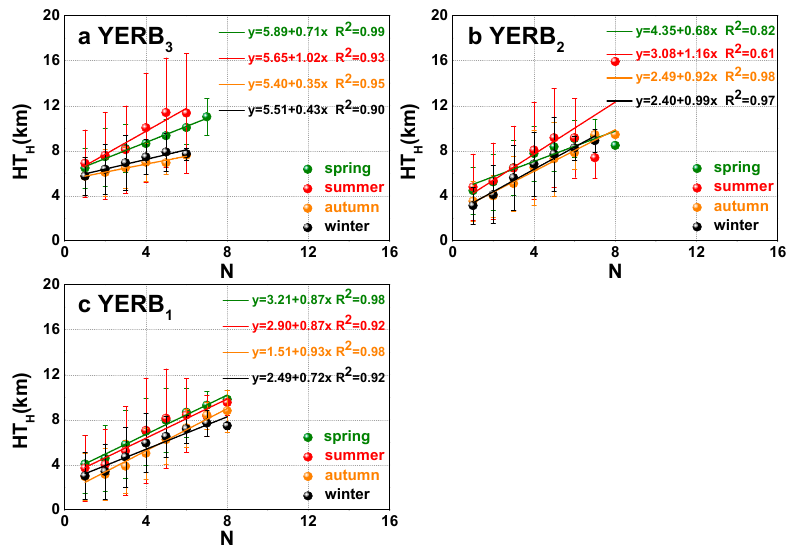
Figure 7. The correlations between the height of the highest aerosol layer top (HT H ) and amount (number) of aerosol feature layers (N) over TP. ( a ) is for YERB 3 , ( b ) is for YERB 2 , and ( c ) is for YERB 1 .